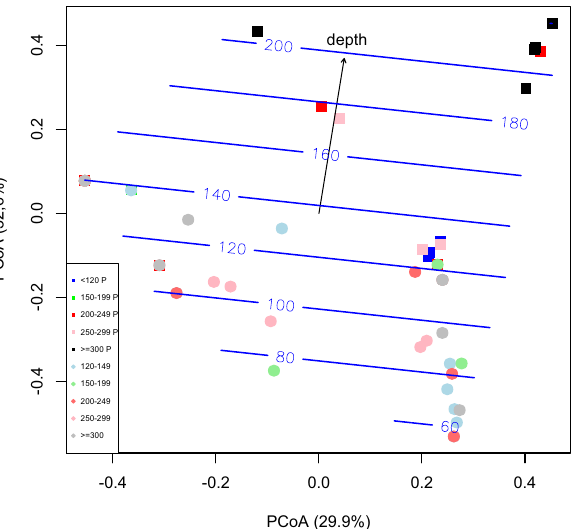
Figure 3. Principal Coordinate Analysis based on Bray–Curtis dissimilarities computed on the occurrence data standardised by Hellinger transformation of samples from all size classes and habitats (permutest P -value = 0.004). Samples collected inside the Pomo Pit (identified in the legend with a P) are depicted as squares, outside the Pomo Pit as dots. The vector and the linear trend surface computed by using sea depth as environmental variable are shown on the PCoA plot (numbers on the splines represent depth values measured in meters). Plot made by using the R program 77